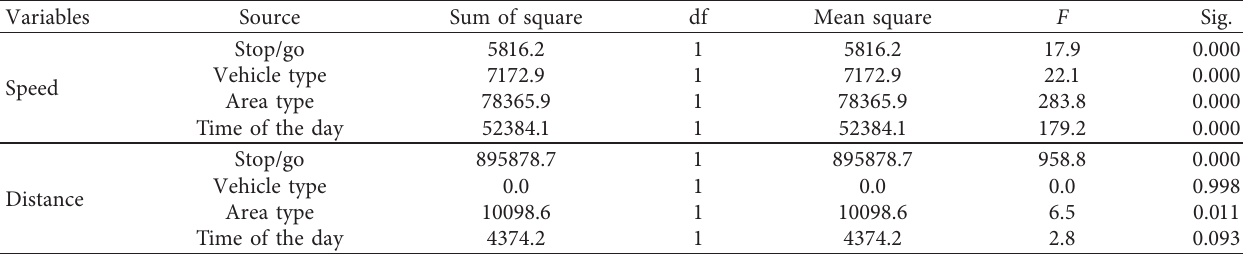
Table 4: Analysis of variance table for speed and distance of FG onset.